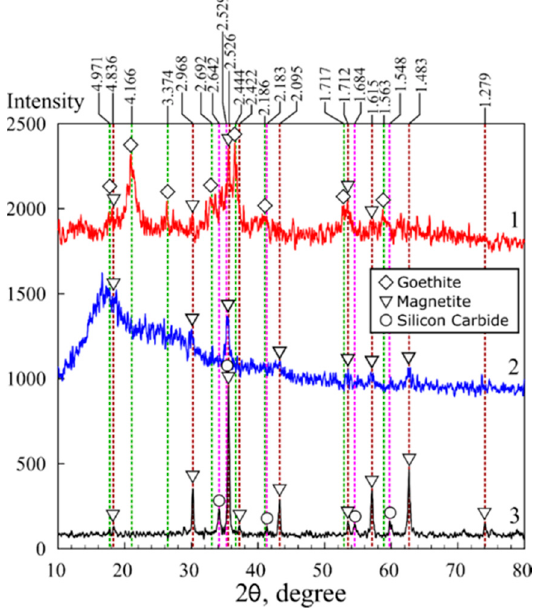
Figure 3. X-ray di ff raction patterns: 1—sorbent 3M, 2—sorbent KU-MAG, 3—sorbent Figure 3. X-ray diffraction patterns: 1—sorbent 3M, 2—sorbent KU-MAG, 3—sorbent MAG.